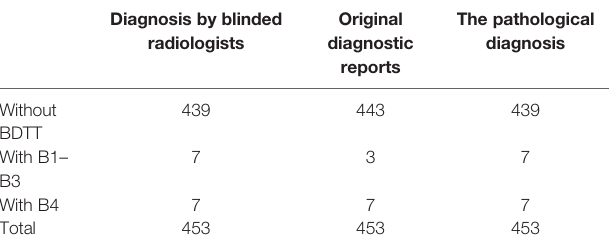
TABLE 5 | A reading test was performed by blinded radiologists for BDTT diagnosis. Diagnosis by blinded radiologists